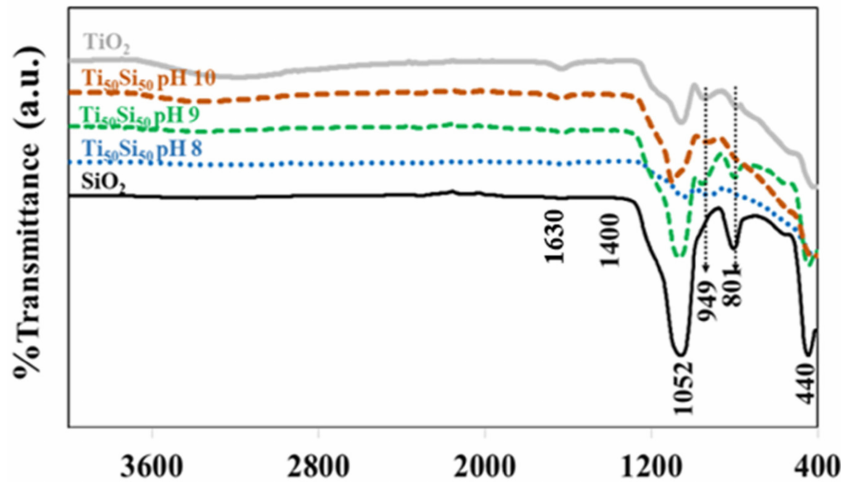
Figure 6. FTIR spectra of TiO 2 , SiO 2 , and Ti x Si y oxides synthesized at pH 8.0, 9.0, and 10.0. Strong bands near 3440 and 1630 cm − 1 can be seen in Figure 6, which are assigned to the streching and deformation vibration of the hydrocyl groups present (TiO 2 –OH) on the surfaces of TiO 2 and all mixed oxide samples. The intensive band of OH-group asymmetrical and symmetrical stretching vibrations at 3440 cm − 1 and O–H